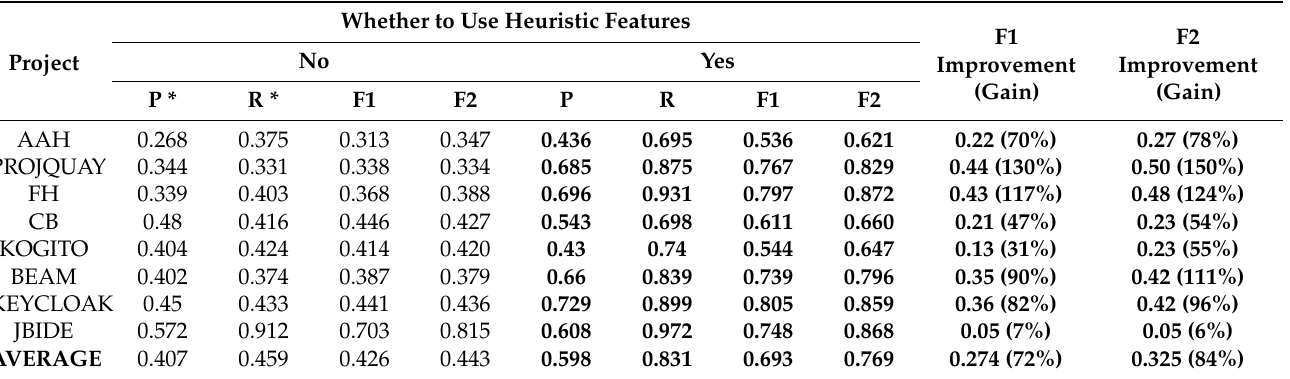
Table 7. Effect of heuristic features on trace link